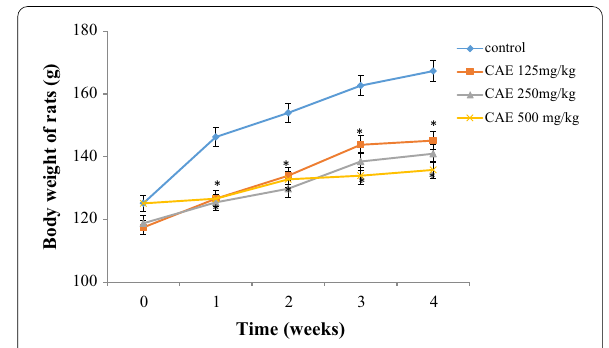
Fig. 1 Weekly body weight of rats following 28-day repeated administration Culcasia angolensis leaves extract (CAE). The values were displayed as mean SEM; * p 0.05 in relation to the control ± ≤ group (repeated measure ANOVA followed by Dunnett’s post hoc test, n 6, CAE Culcasia angolensis leaves =